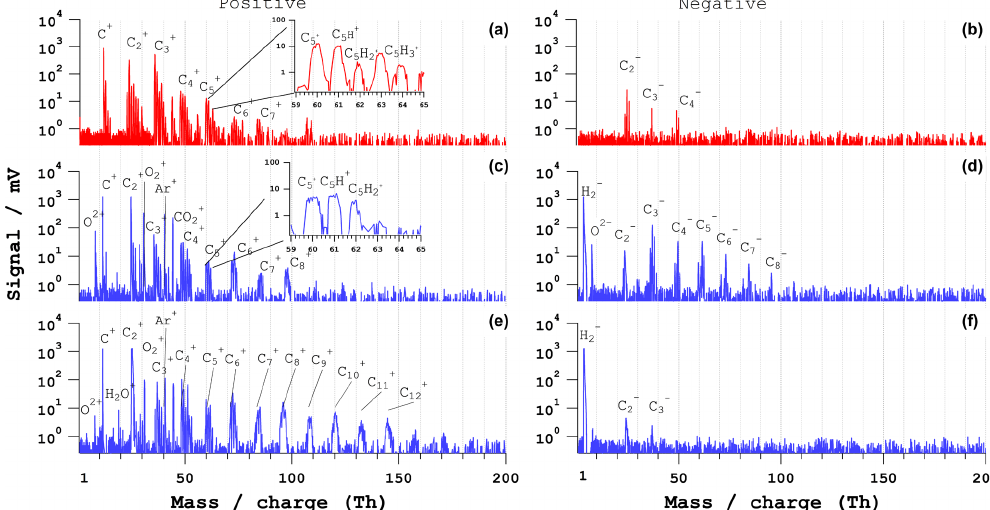
Figure 3. Bipolar mass spectra of single PSL particles of d p = 500nm. (a, b) Typical ns-laser spectra, (c, d) fs-laser ( λ = 800nm) spectra for 54% of particles (type 1), and (e, f) fs-laser ( λ = 800nm) spectra for 42% of particles (type 2). The pulse energy is 4mJ for the ns laser and 3.2mJ for the fs